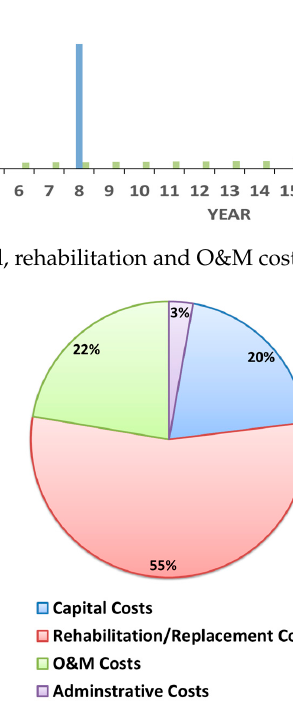
Figure 8. E ff ective percentage of each cost component over 25 years lifetime of project. Figure 8. Effective percentage of each cost component over 25 years lifetime of project. Table 3. Cost categories during the life cycle of the project.